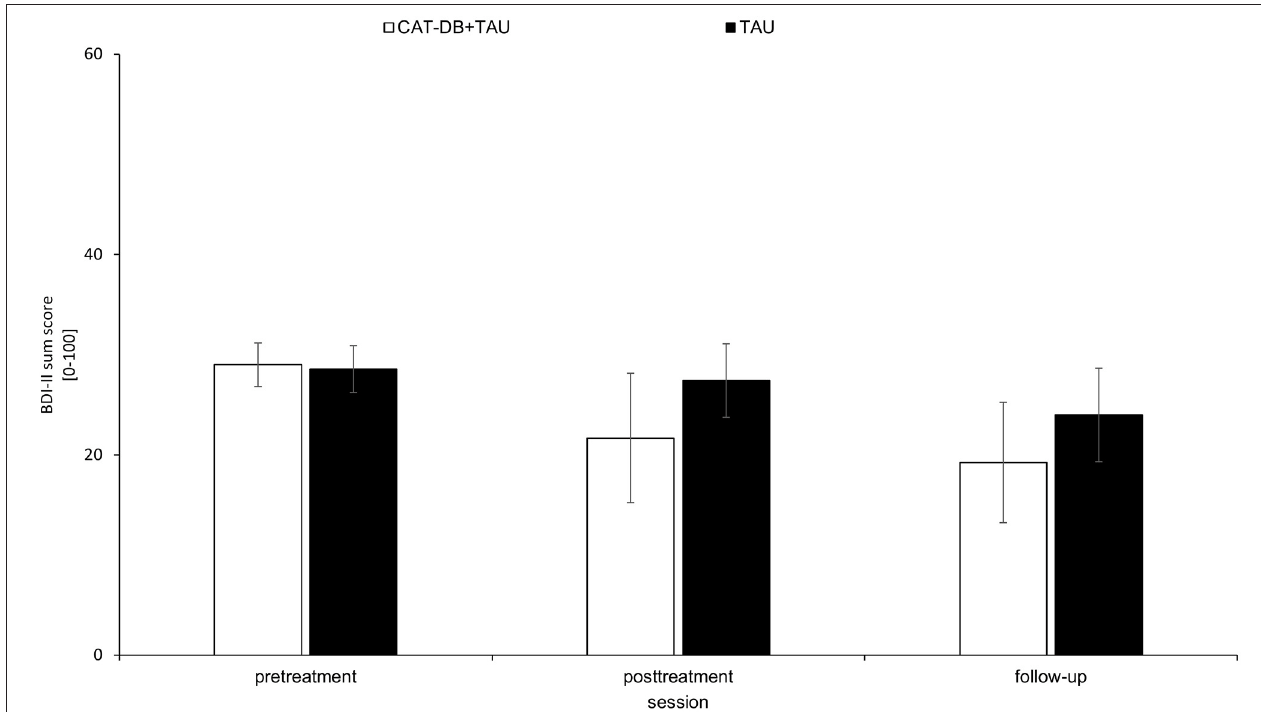
FIGURE 5 | BDI-II sum score in the CAT-DB + TAU group ( n = 16) and the TAU group ( n = 14) at pre-treatment, at post-treatment and at follow-up. Error bars represent standard